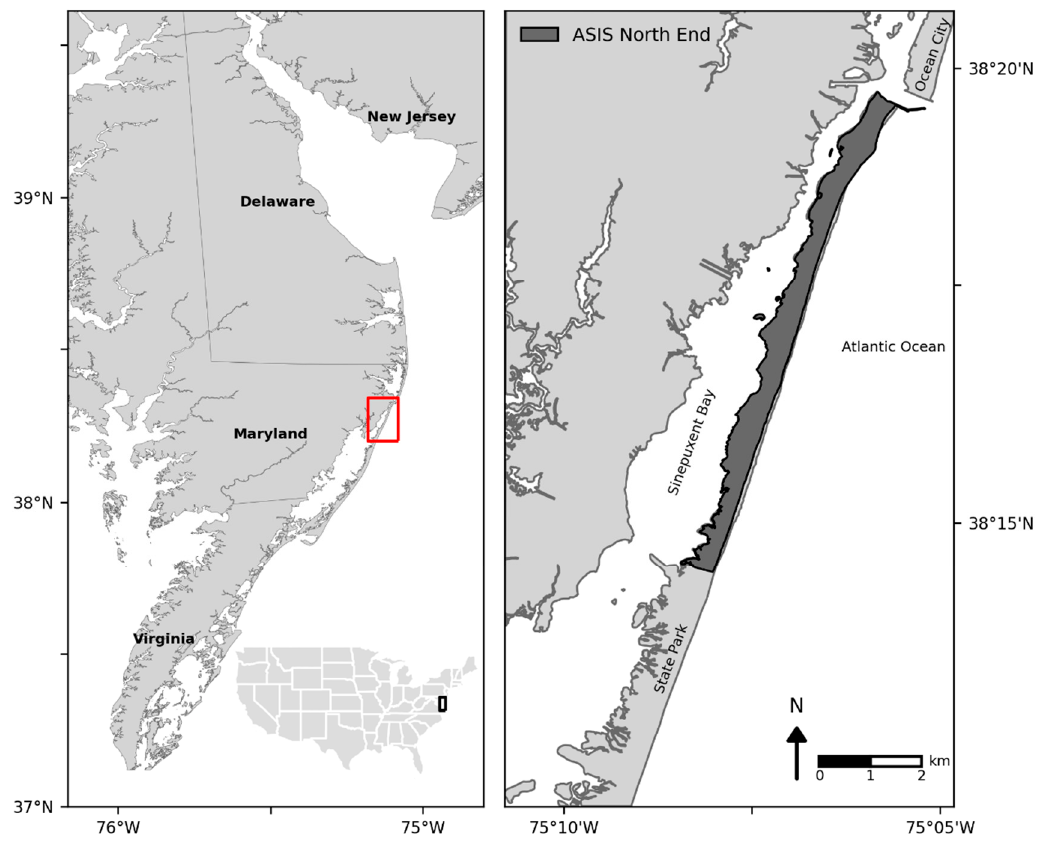
Figure 1. Site map of North End of Assateague Island (ASIS), shown in dark